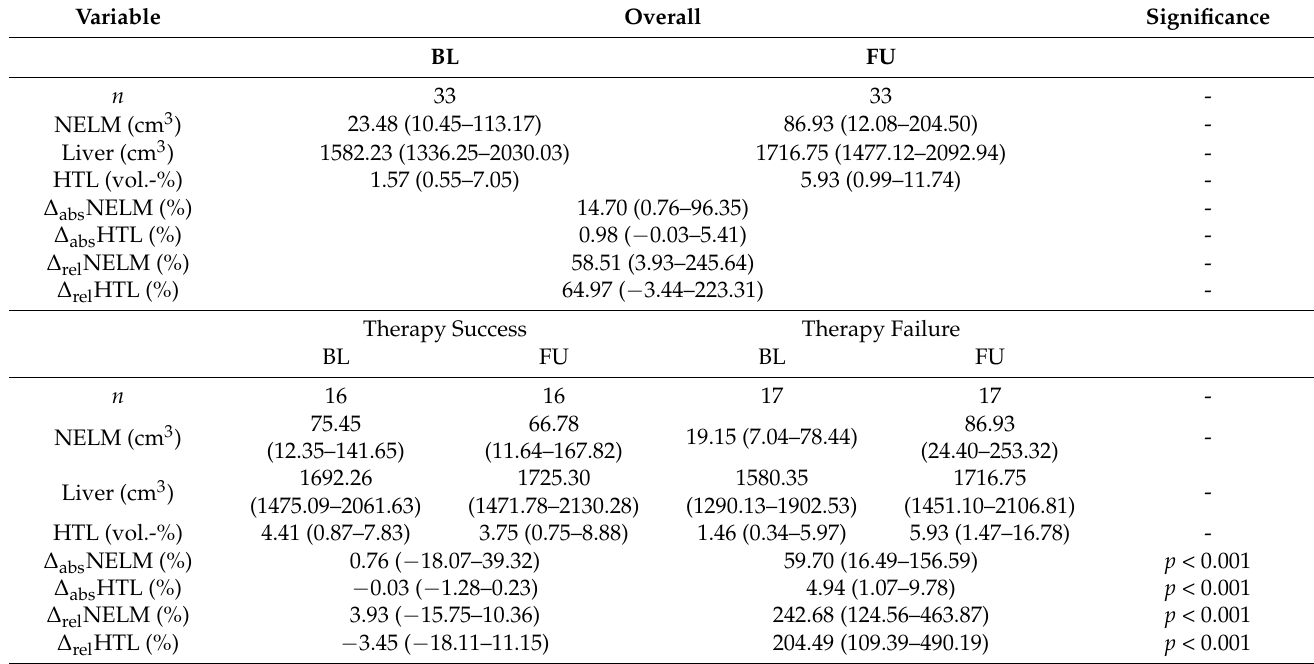
Table 2. Summary of the model’s segmentation results for the MCC cohort and their absolute and relative changes between baseline and follow-up MRI examinations.